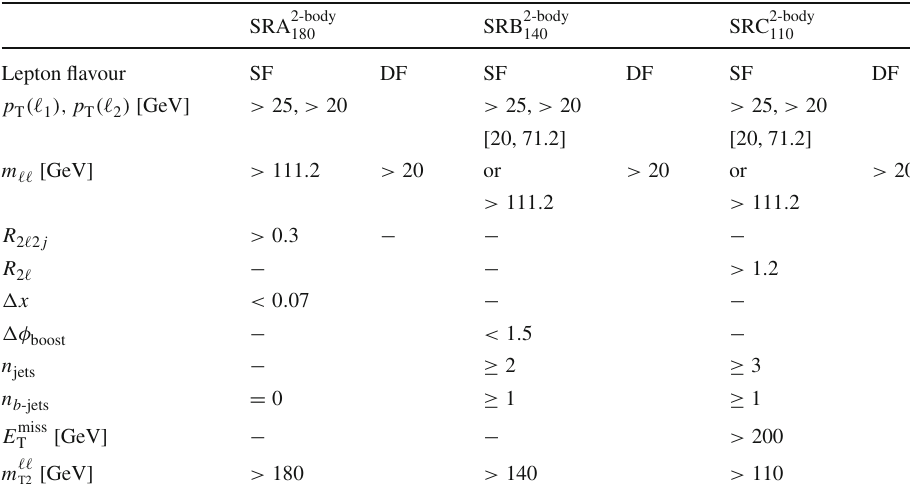
Table 2 Two-body selection signal region